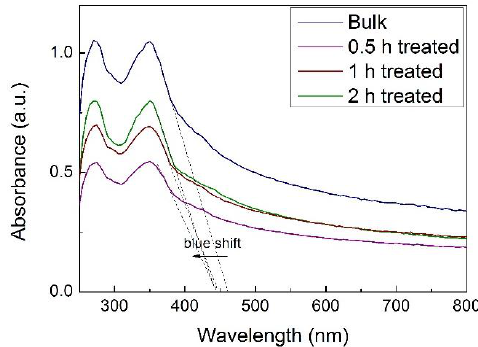
Figure 3. UV-Vis absorption spectra of diluted bulk g-C 3 N 4 and as prepared g-C 3 N 4 nanosheets exfoliated at different acid treatment